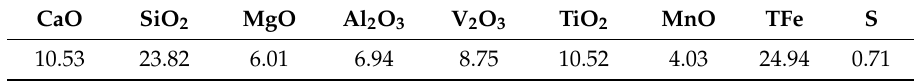
Table 2. Compositions of vanadium slag. (wt. %).